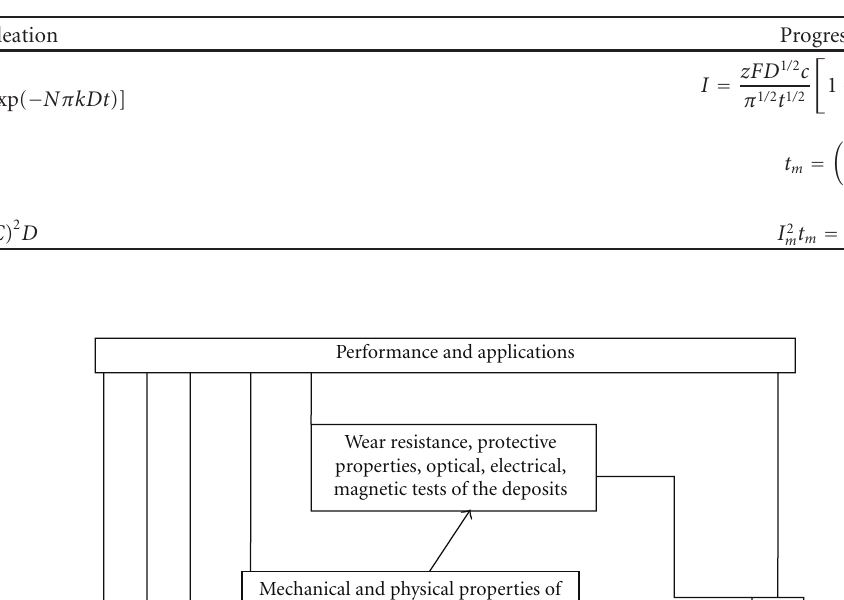
Table 1: Current expressions and their kinetic parameters from SH model.